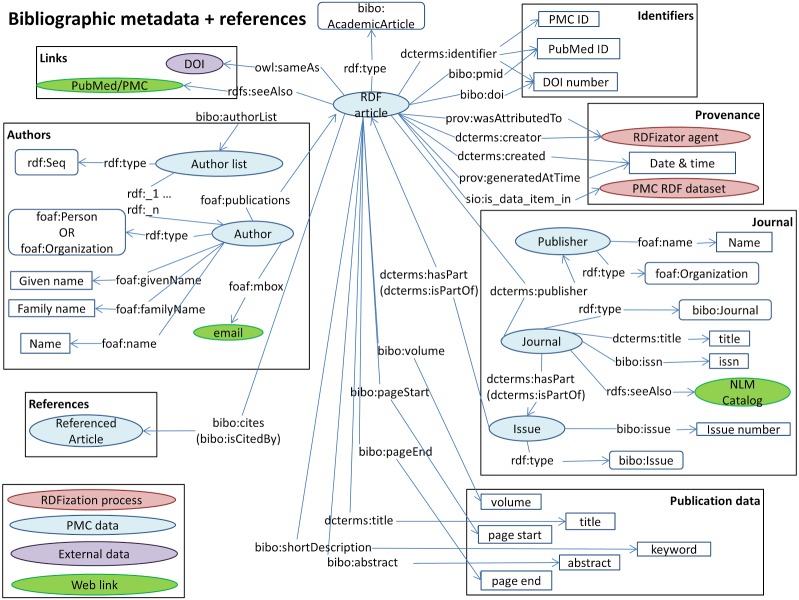
The Biotea model.